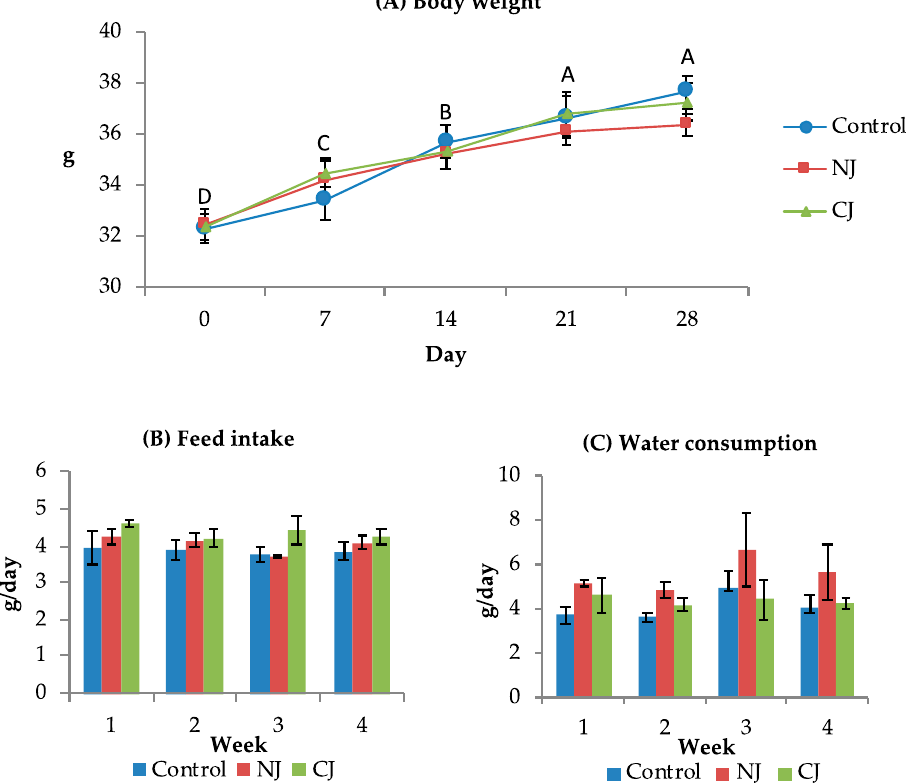
Figure 1. Means ± SEM of the mice body weight (BW) ( A ), feed intake ( B ), and water consumption ( C ). Mice groups received water (control), natural juice (NJ), or clarified juice (CJ) by oral gavage. A–D: di ff erent letters indicate significant di ff erences among timepoints p < 0.01. No statistically significant interaction Group × Time was